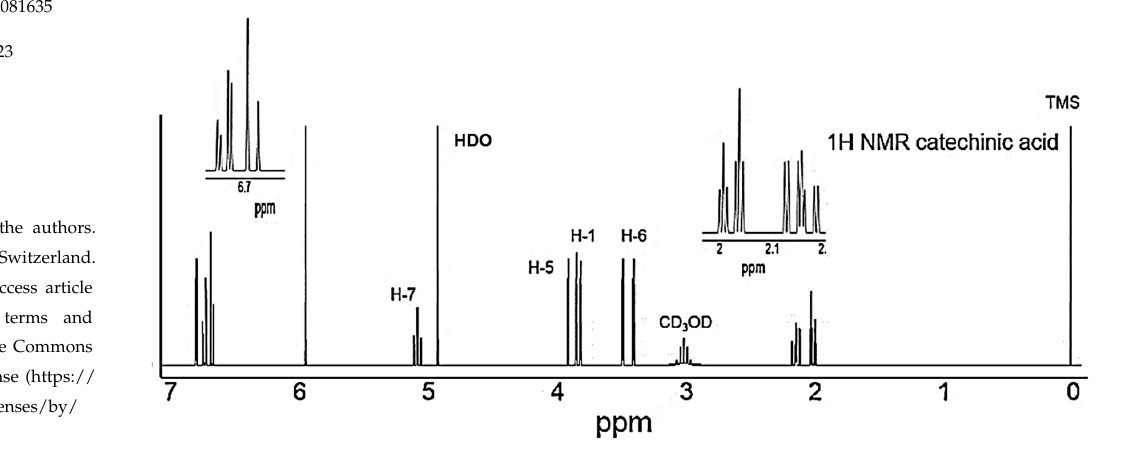
Figure 6 was published with horizontal orientation instead of vertical one. The graph has also been corrected in the original publication. In Figure S3 of the Supplementary Materials, CD 3 OD was written in place of HDO near the peak at about 4.8 ppm on the 1 H NMR spectrum of catechinic acid (CA). The corrected Figure S3 appears below.